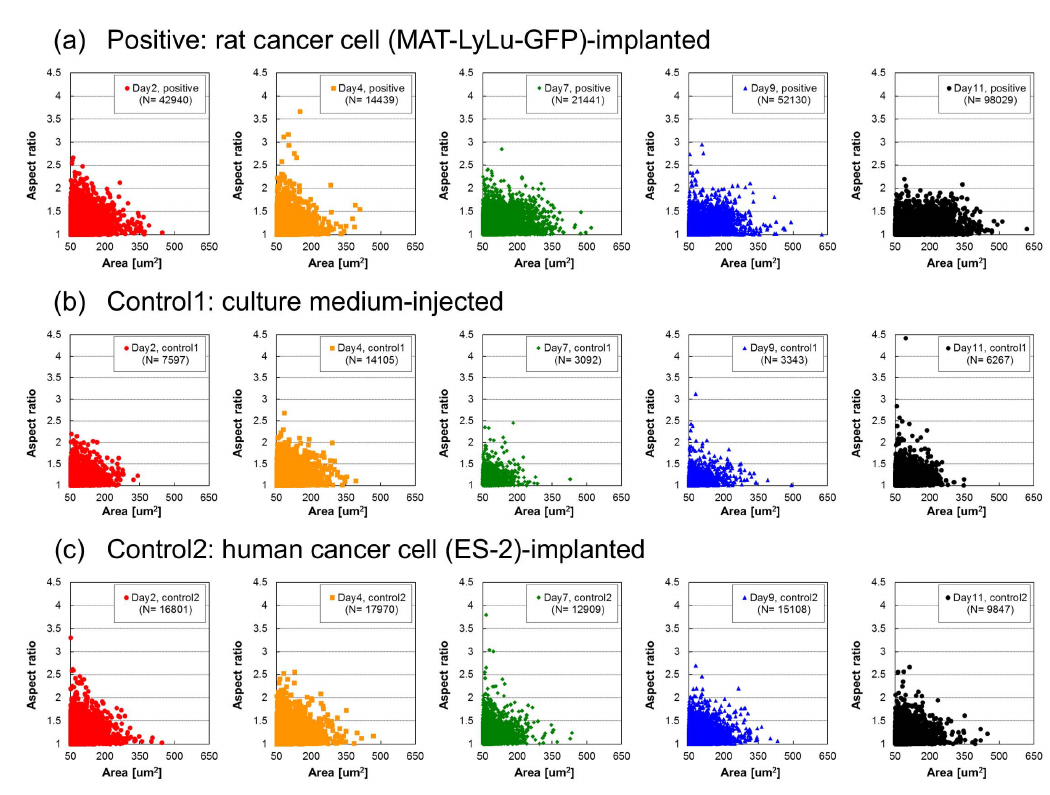
Figure 8. Cell size dependence of aspect ratio distribution of BF cell areas in positive ( a ), control 1 ( b ), and control 2 ( c ) blood of the same samples as in Figure 4. Each distribution graph is from 2, 4, 7, 9, or 11 days after the implantation of rat cancer cells ( a , positive), culture medium ( b , control 1), or human cancer cells ( c , control 2). Measurements were performed for six rats for positive cases and three for controls. Each dot represents the cell size–aspect ratio of each